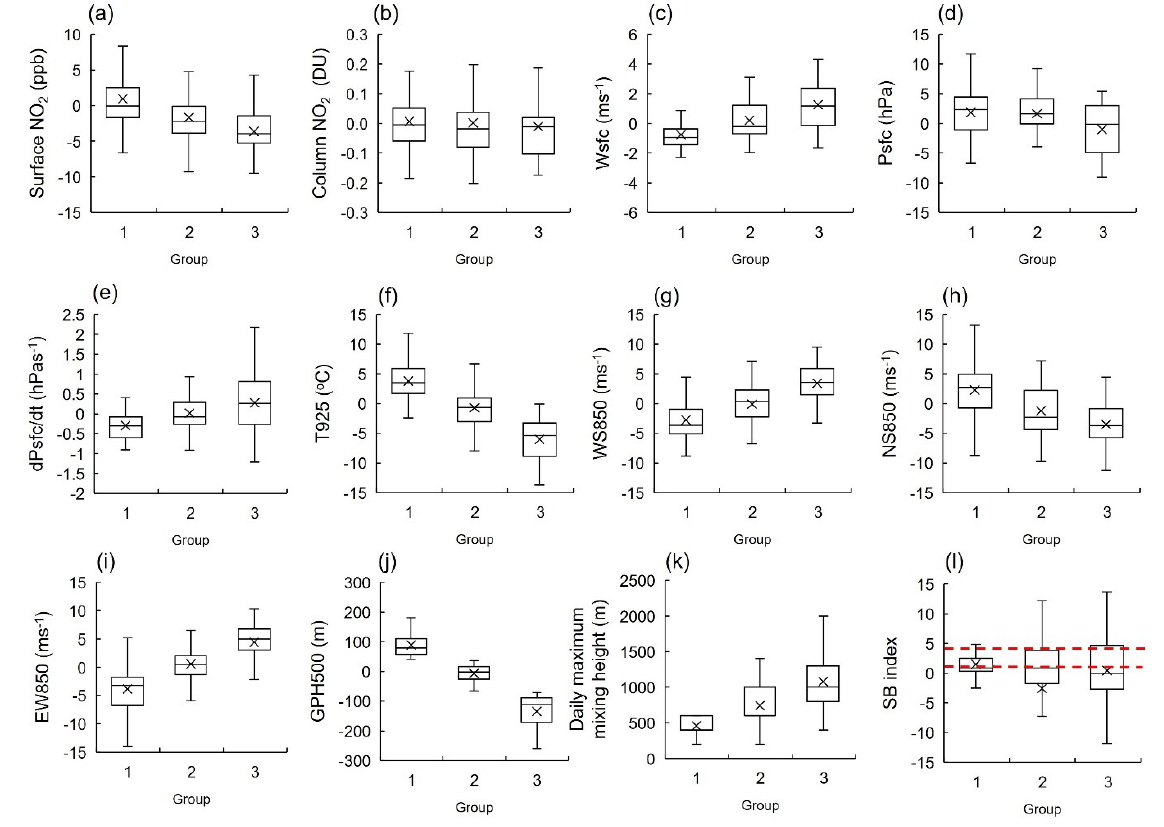
Figure 4. K -means clustering yielded three groups of cases for (a) surface NO 2 and (b) PC-NO 2 , associated with eight meteorological variables: (c) surface wind speed (Wsfc), (d) Psfc, (e) Psfc tendency (dPsfc / d t ), (f) 925hPa air temperature (T925), (g) 850hPa wind speed (W850), (h) 850hPa north–south wind component (NS850), (i) 850hPa east–west wind component (EW850), and (j) 500hPa geopo- tential height (GPH500). All data were de-seasonalized using the 30d moving average, except PC-NO 2 , for which the monthly average was used. (k) Simulated daily maximum mixing height (not directly clustered). (l) Box and whisker plots of the sea breeze index (SBI) at Seosan for the 1-year period. Red dots indicate the critical SBI (a value of 3), suggested by Biggs and Graves